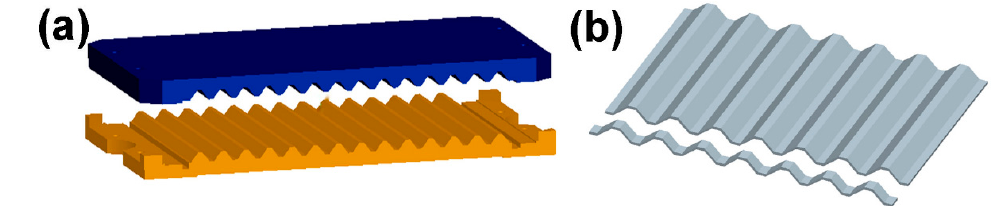
Figure 1. ( a ) Corrugated mold ( b ) Shaped corrugated sheet cut into strips.